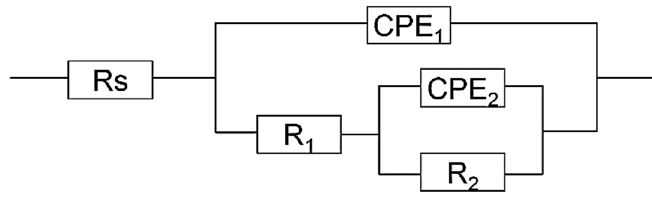
Figure 3. Equivalent circuit for EIS fitting. Table 2. EIS fitting data of 2205 DSS in HCl solution with different Na 2 S at 90 °C.